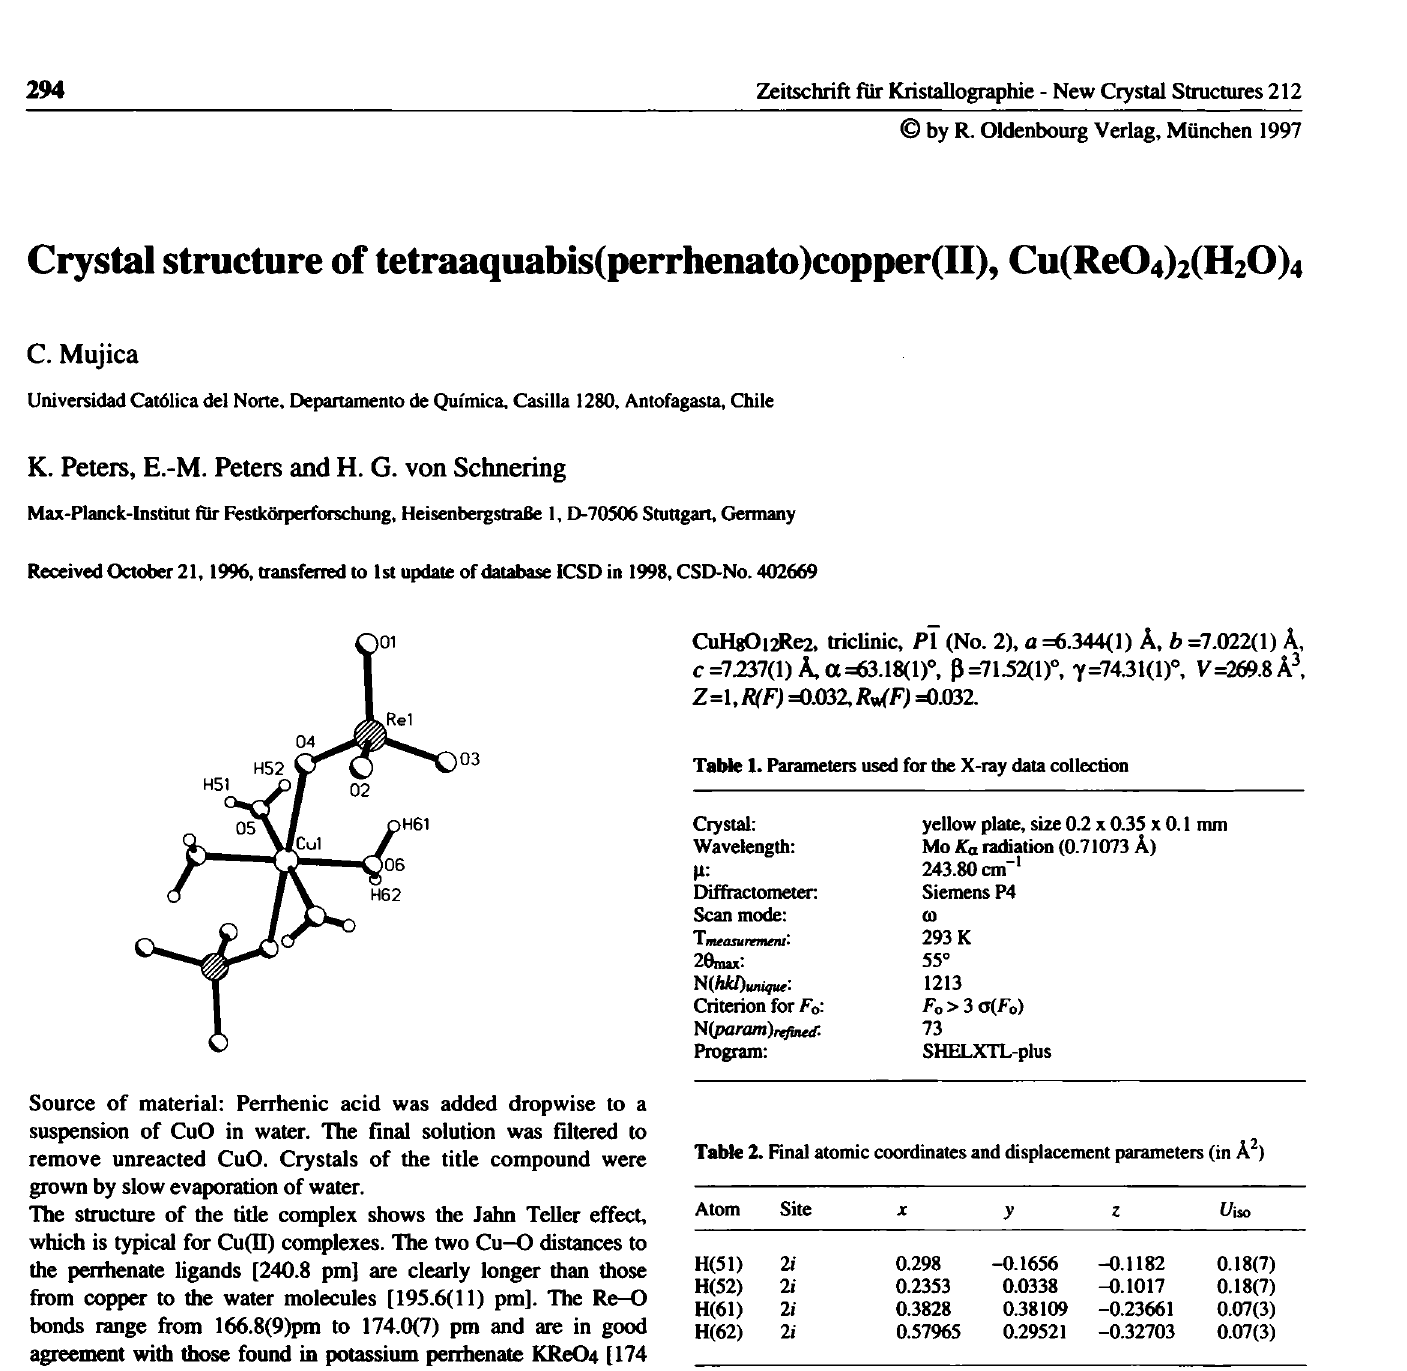
Table 3. Final atomic coordinates and displacement parameters (in Â 2 )